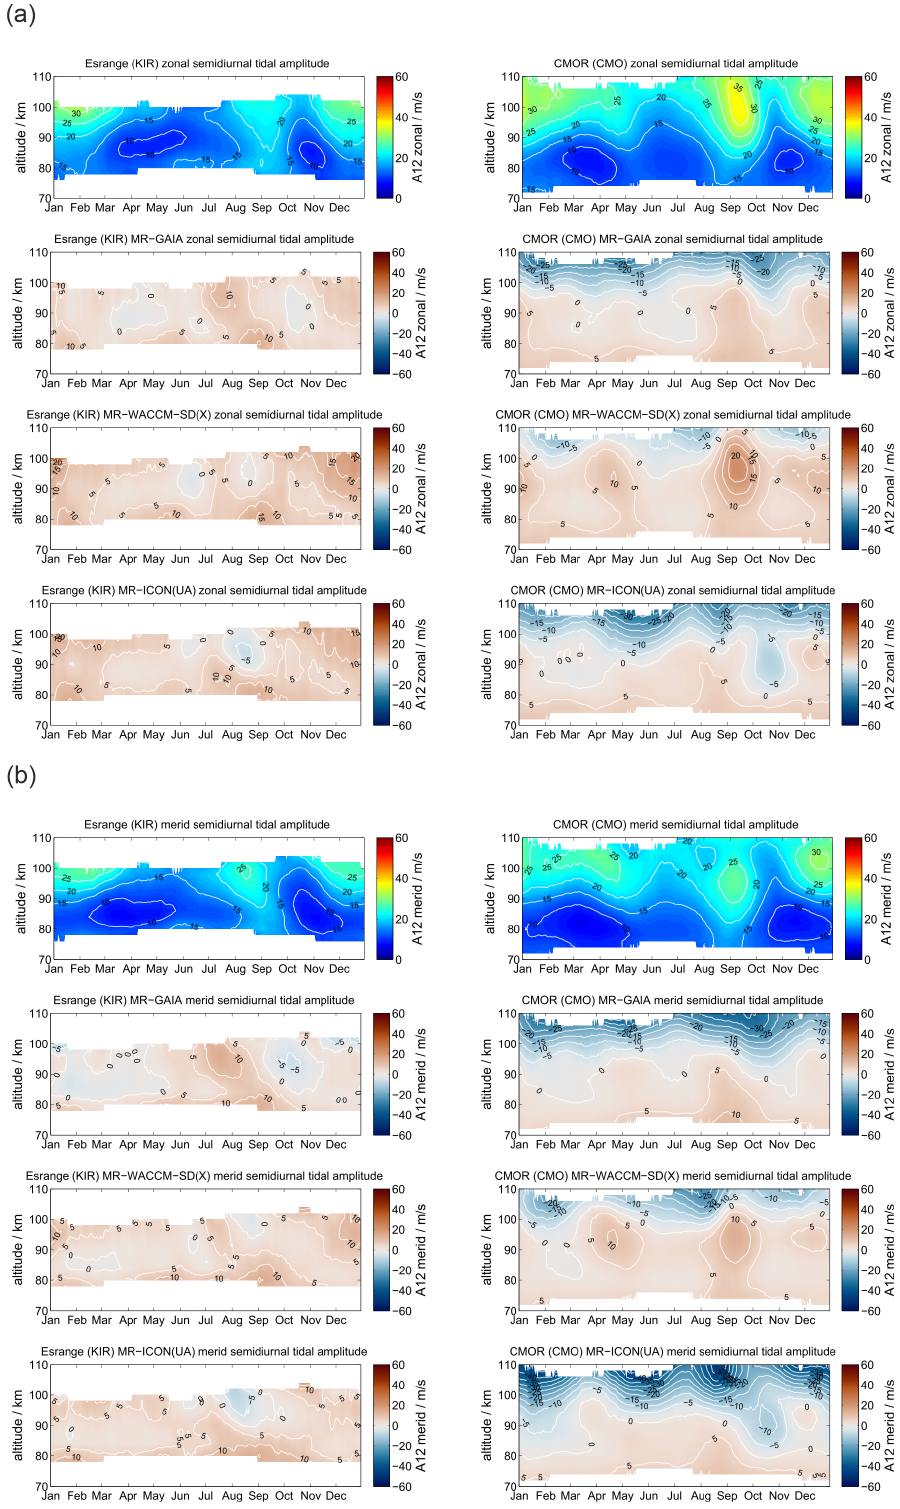
Figure D3. The same as Fig. D1, but for KIR and